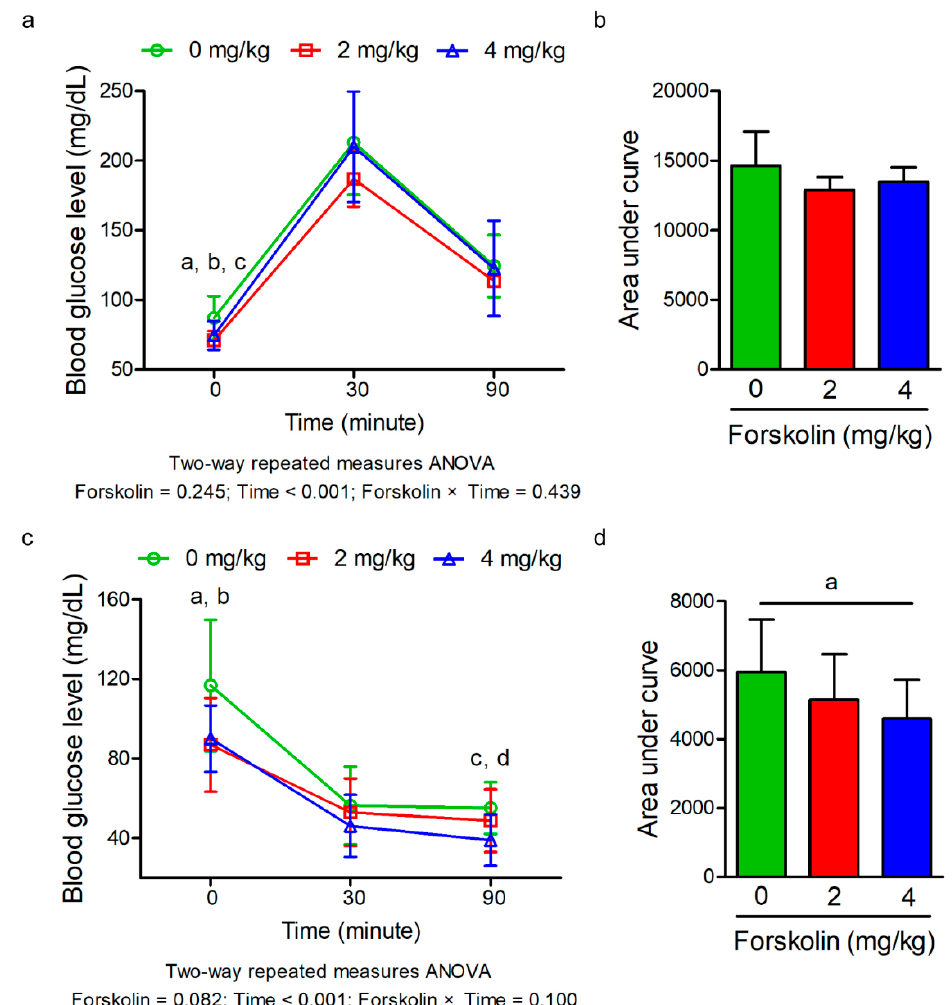
Figure 2. Effect of forskolin on glucose metabolism of high-fat diet-induced obesity in mice. ( a ) Blood glucose levels of high-fat diet-fed mice in response to glucose tolerance test. Data are average blood glucose levels of 8 mice per treatment. a p value = 0.025 by one-way ANOVA. b p value = 0.054 by linear contrasts. c p value = 0.057 by quadratic contrasts. ( b ) Area under curve of high-fat diet-fed mice in response to glucose tolerance test. Data are average blood glucose levels of 8 mice per treatment. The bars indicate mean ± SD. ( c ) Blood glucose levels of high-fat diet-fed mice in response to insulin tolerance test. Data are average blood glucose levels of 8 mice per treatment. a p value = 0.053 by one-way ANOVA. b p value = 0.052 by linear contrasts. c p value = 0.090 by one-way ANOVA. d p value = 0.028 by linear contrasts. ( d ) Area under curve of high-fat diet-fed mice in response to insulin tolerance test. Data are average blood glucose levels of 8 mice per treatment. The bars indicate mean ± SD. a p value = 0.050 by linear contrasts.